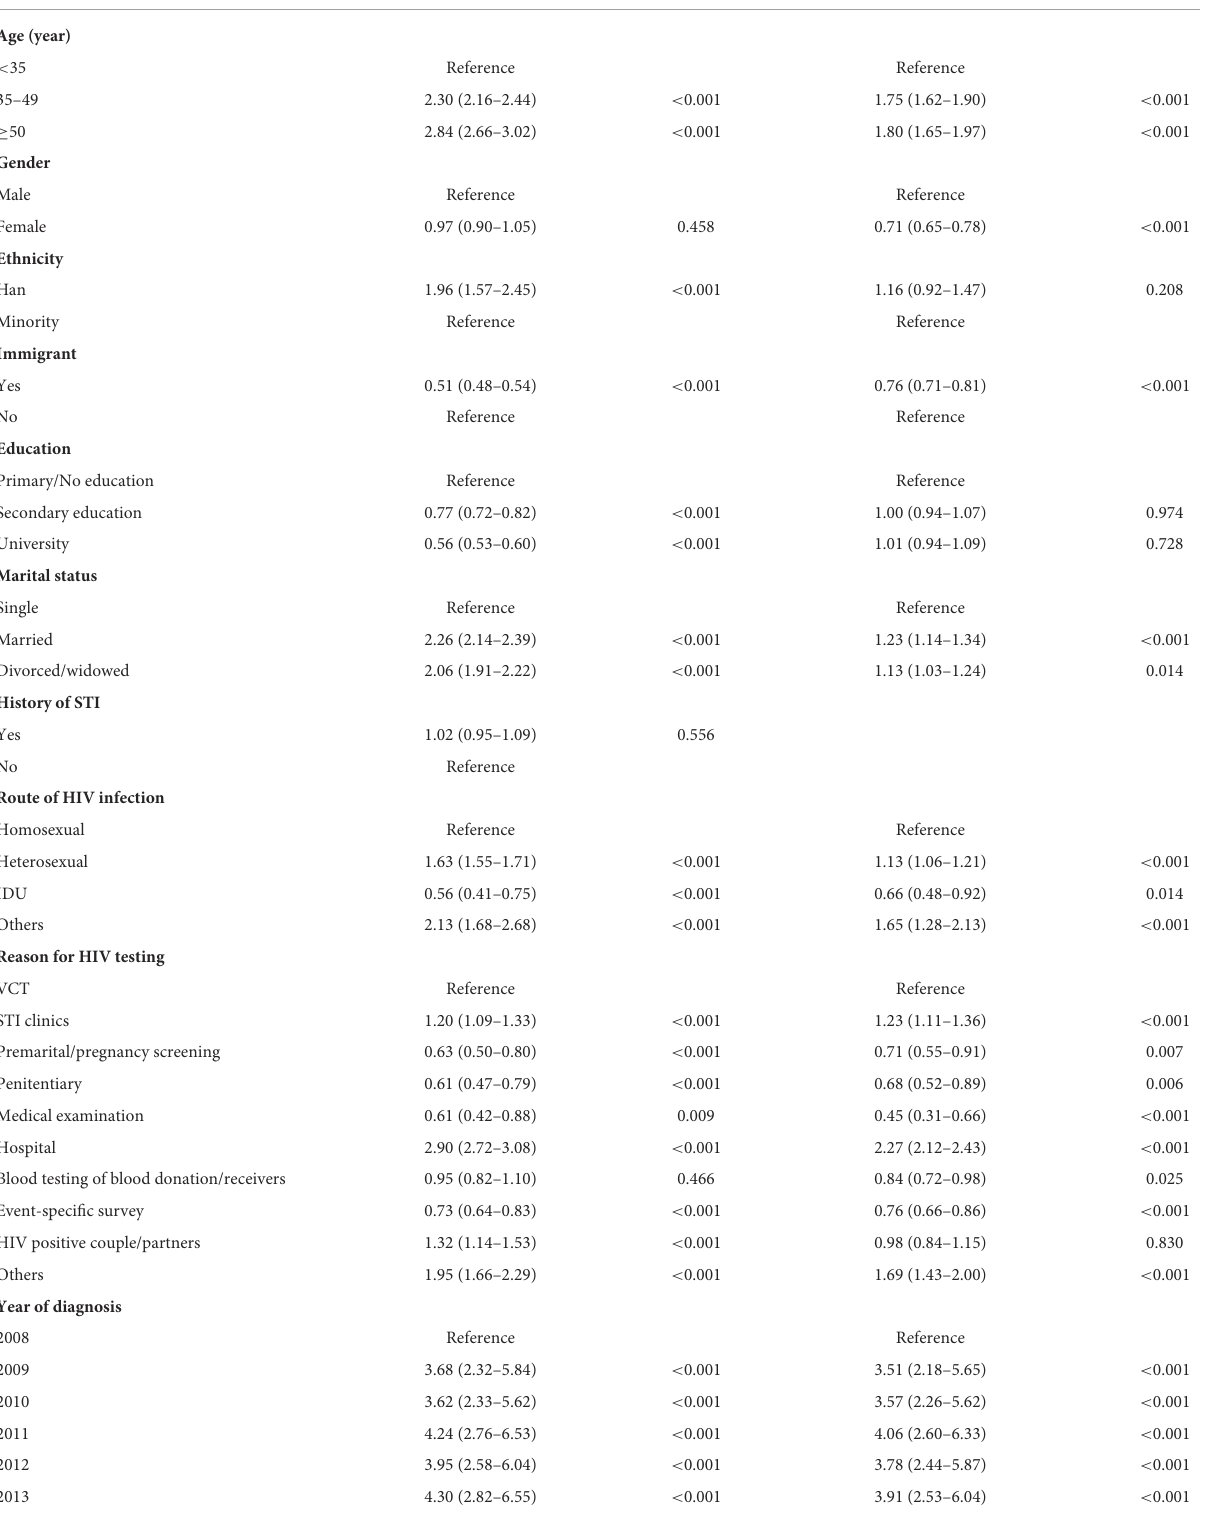
TABLE 3 Risk factors associated with advanced HIV disease presentation in Jiangsu province, China, 2008–2020. Characteristics at HIV